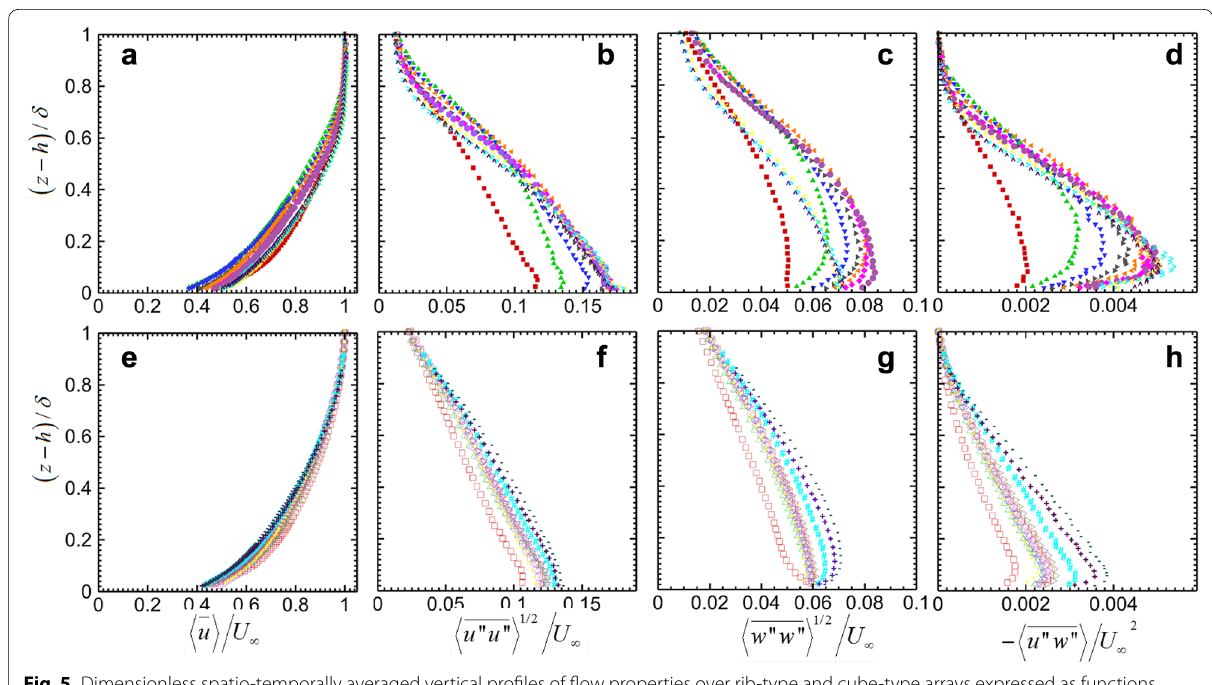
1 / 2 u ′′ u ′′ ; c , g vertical fluctuating (cid:31) (cid:30)